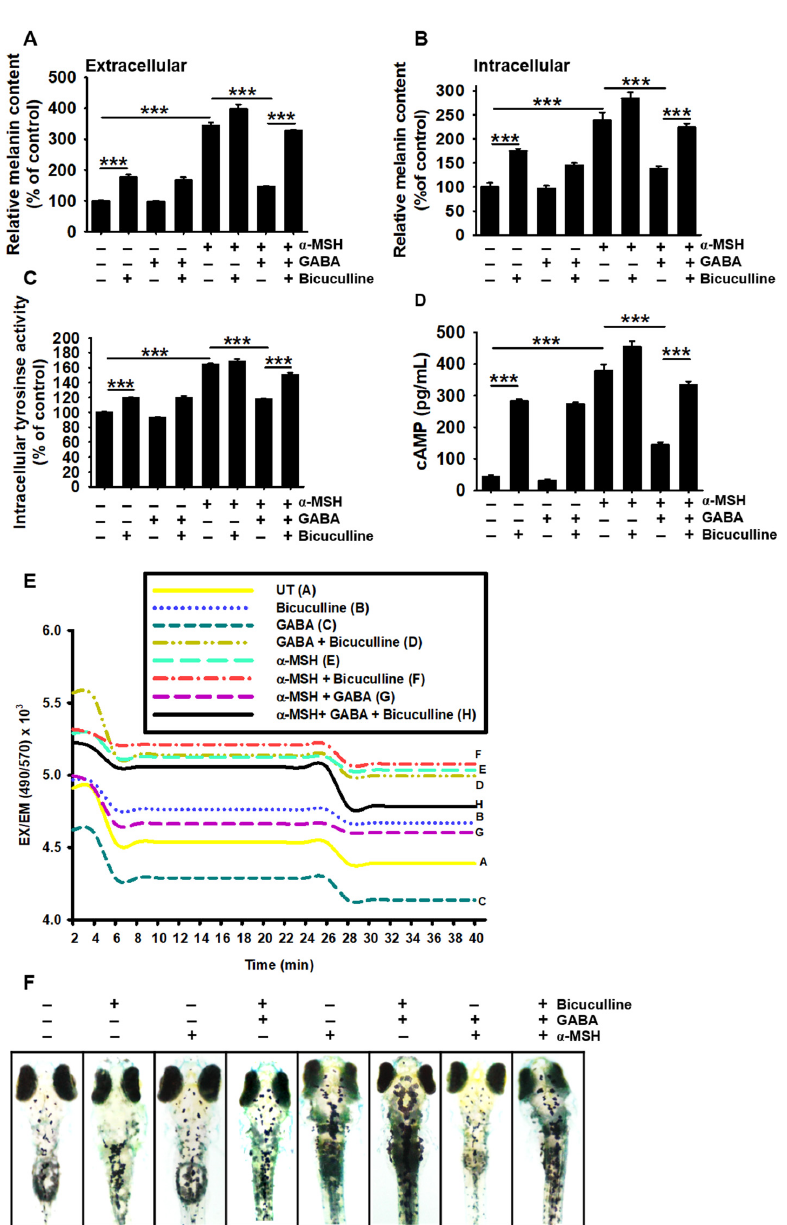
Figure 5. Bicuculline reverses the antimelanogenic properties of GABA in B16F10 melanoma cells and zebrafish larvae. B16F10 melanoma cells (5 × 10 4 cells/mL) were pretreated with 10 µM (+)- bicuculline for 2 h prior to treatment with 20 mM GABA and 500 ng/mL α -MSH. ( A ) Extracellular and ( B ) intracellular melanin contents were measured. ( C ) Intracellular tyrosinase activity was measured 72 h after treatment with GABA and α -MSH, and ( D ) cAMP level was determined at 15 min. ( E ) The cells were stained with 1 µM Fluo-4 AM for 10 min after treatment with GABA and/or α -MSH for 1 h, and fluorescence intensity was measured using a luminometer. ( F ) Three days post- fertilized zebrafish larvae were pretreated with 10 µM bicuculline for 2 h before treatment with 50 mM GABA and 1 µg/mL α -MSH for an additional 72 h. Images were captured using a stereomicro- scope (4×). The results represent the average of data obtained from three independent experiments and are expressed as the mean ± standard error of the mean (SEM) ( *** p < 0.001 and * p < 0.01). GABA, gamma-aminobutyric acid; α -MSH, α -melanocyte-stimulating hormone; cAMP, cyclic adenosine monophosphate.